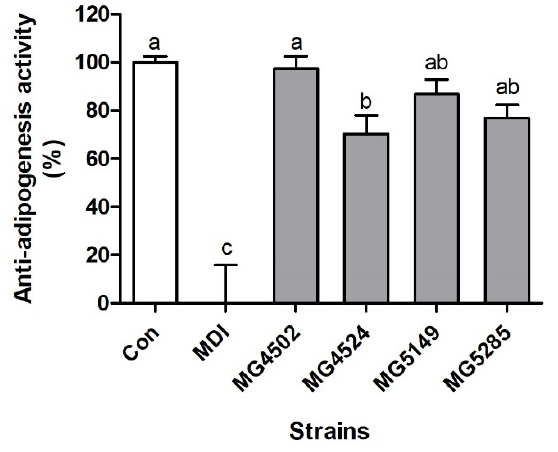
Figure 3. Inhibitory effects of probiotic candidates on adipogenesis in 3T3-L1 cells. Con is the control without MDI treatment and MDI is the control with MDI treatment. Samples were treated with MDI and CFE. All values are presented as the means ± SD from three independent experiments. Different letters indicate significant differences between means at p < 0.05 by Tukey’s multiple comparison tests. Table 1. Correlation analysis of the biological activities of the lactic acid bacteria.